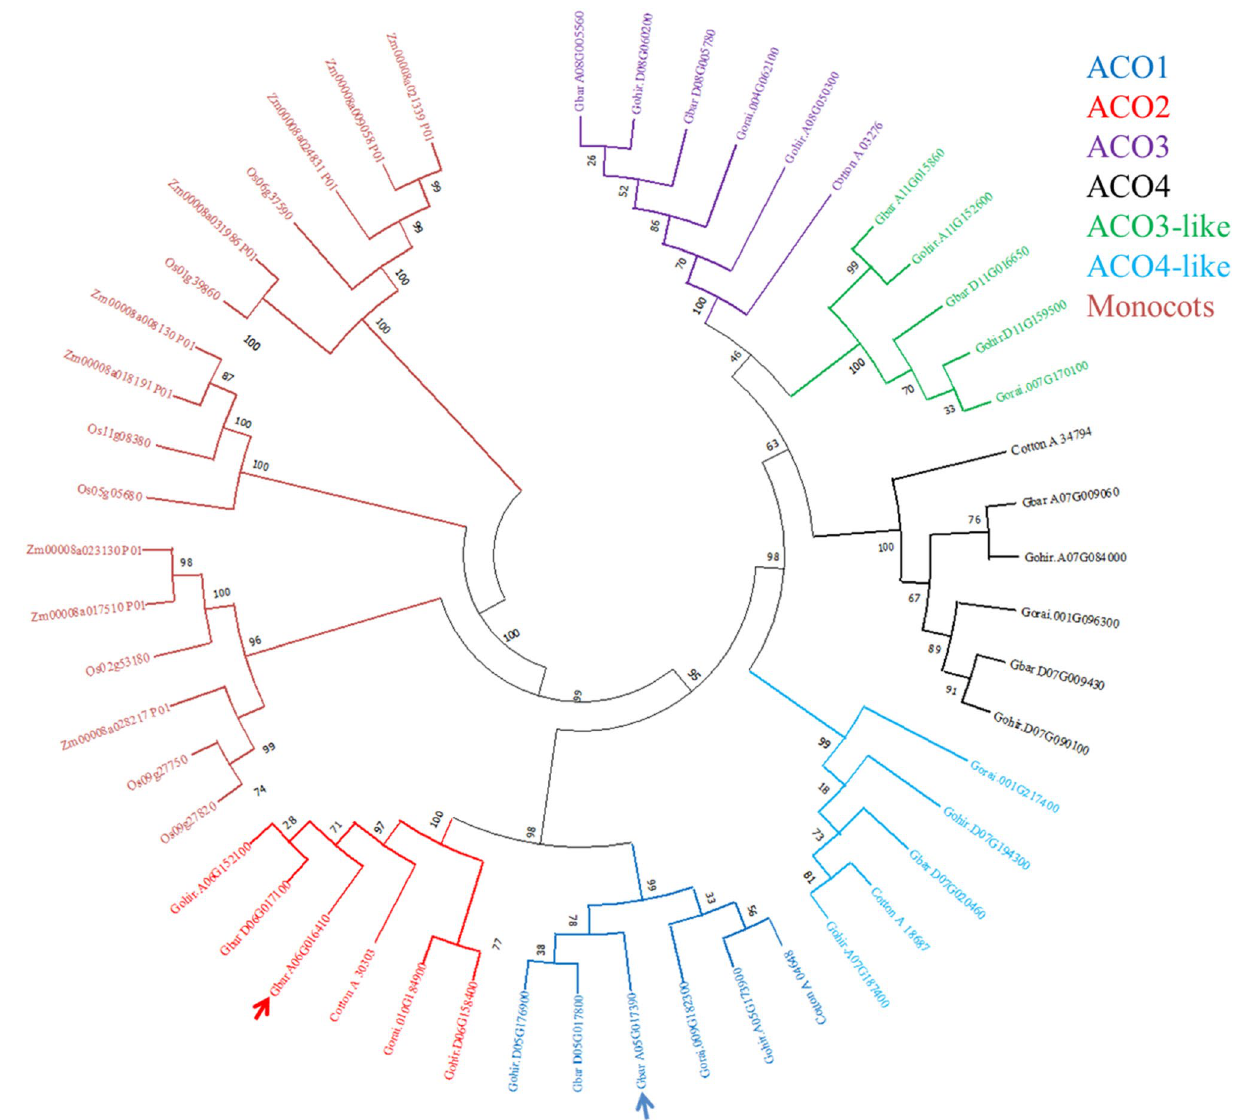
Figure 4. Classification of ACO isoforms in Gossypium spp. ( G. arboreum , G. raimondii , G. hirsutum and G. barbadense ) and monocotyledonous species ( O. sativa and Z. mays ). Arrow heads indicate the homologous sequences of isolated genes. The number at each node indicates the percent bootstrap